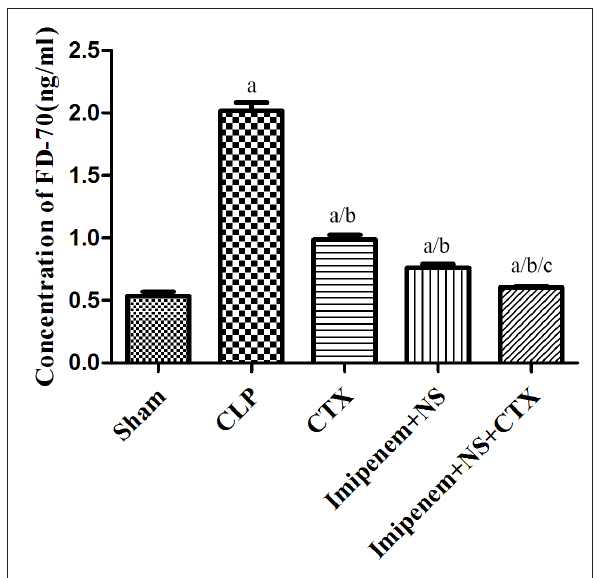
Fig. 5. The quantitative analysis of the apoptosis levels of intes- tinal mucosal cells. The values are expressed as mean ± SD. The statistically signifi- cant difference is expressed at p-value of less than 0.05 ( P <0.05). Compared to the sham group, there was statistically significant difference ( P <0.05); Compared to the CLP group, there was statistically significant difference ( P <0.05).